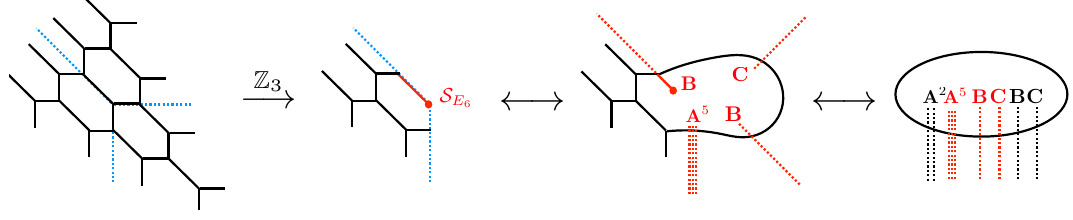
Figure 21 . The Z 3 quotient of T 4 theory. We insert A 5 BCB at the vertex connected to the (1 , − 1) 5-brane line. This leads to a 7-brane configuration for SU(2) + 7 F theory which has an E symmetry in CFT limit.